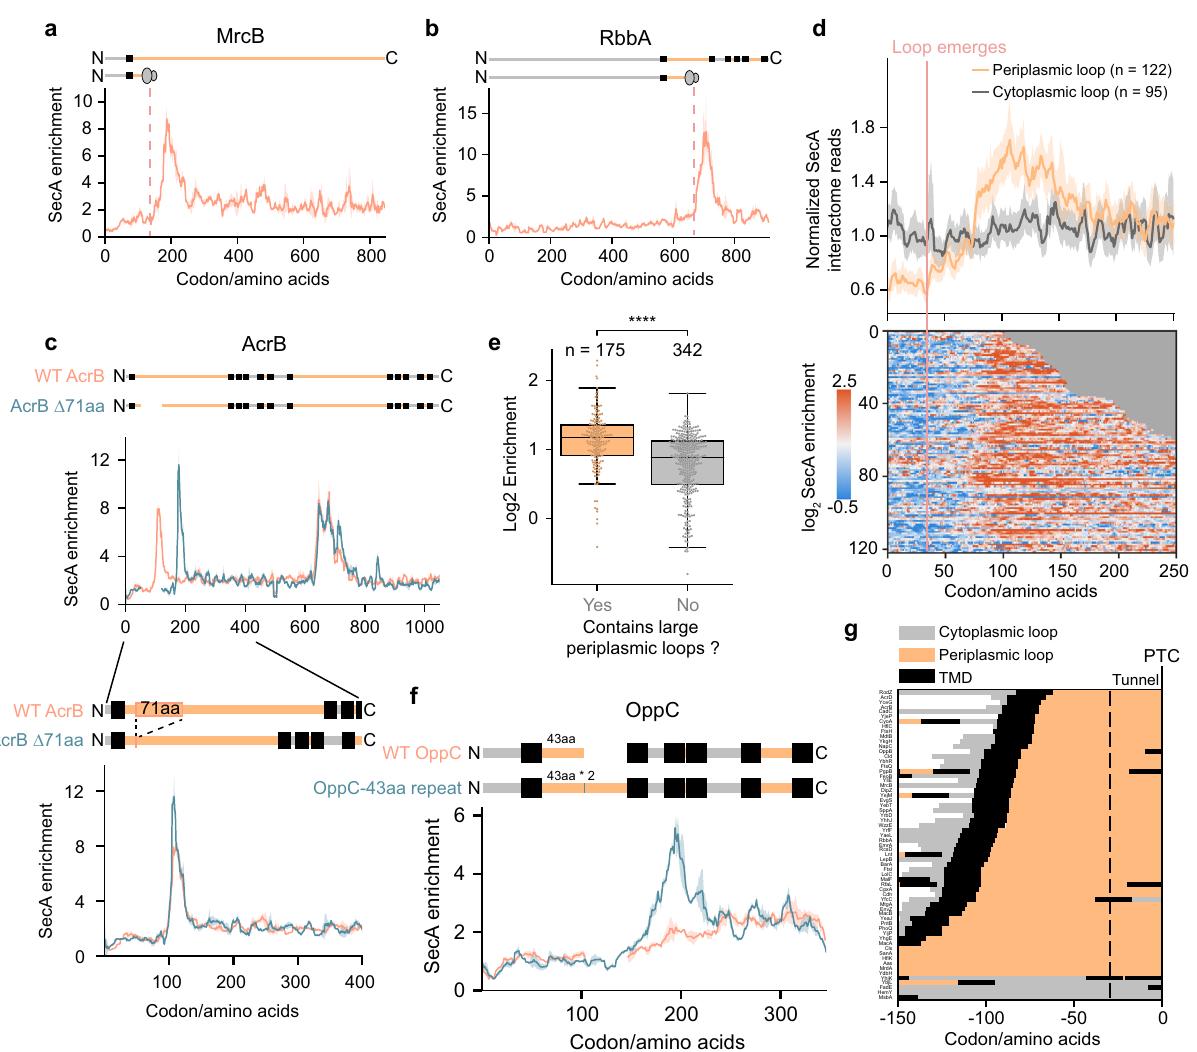
Fig. 3 SecA cotranslationally translocates large periplasmic loops of IMPs. a , b Representative SecA interaction pro fi les of IMPs with large periplasmic loops. Protein topology is shown above and colored as in Fig. 2b. c Upper panel, comparison of SecA interaction pro fi le of WT AcrB and AcrB- Δ 71aa. The topology of the protein is shown above and colored as in Fig. 2b. The deleted region was skipped in the indicated protein topology and SecA interaction pro fi le of AcrB- Δ 71aa so that SecA enrichment at each codon corresponds to the same protein sequence between WT AcrB and AcrB- Δ 71aa. Lower panel, zoom in of the fi rst 400 codons. SecA enrichment is plotted as a function of ribosome position relative to the start codon for each protein. aa, amino acids. d Metagene SecA interactome pro fi le of periplasmic and cytoplasmic loops larger than 100 amino acids aligned to their N-terminus. The heatmap below shows the log 2 SecA enrichment at each codon for all the periplasmic loops used to derive the metagene SecA interactome pro fi le, sorted by the length of each periplasmic loop. e Comparison of gene-level enrichment between proteins with and without a large periplasmic loop. f Comparison of SecA interaction pro fi le of WT OppC and OppC-43aa repeat, which contains two tandem copies of the 43aa periplasmic loop in WT OppC. Protein topology is shown above and colored as in Fig. 2b. The inserted region (43 amino acids) was skipped in the protein topology and SecA interaction pro fi le of WT OppC so that the SecA enrichment at each codon corresponds to the same protein sequence between WT OppC and OppC-43aa repeat. aa, amino acids. g Topology of translated nascent chains of strong SecA interactors at the onset of SecA binding. The nascent chains are aligned to their C-terminus (position 0, at PTC) and the residues to the left of the dashed line are exposed outside the ribosomal tunnel exit. In a – c and f , solid lines show the mean values, and shaded areas show the range of data from two independent biological replicates. In d , solid lines show the mean values, and shaded areas show the 95% CI. In e , the centre lines show the median, the boxes show the range of data between the upper and lower quartiles, and the whiskers indicate 1.5x the interquartile range. P = 8.326e − 17 , from two-sided Wilcoxon rank-sum